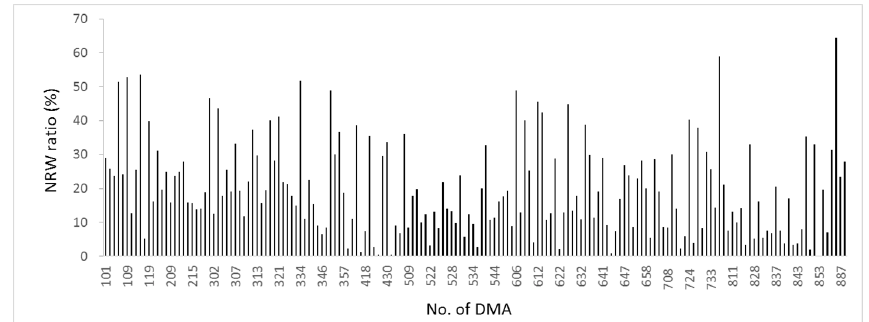
Figure 4. Data Status of NRW ratio in Incheon’s DMAs.